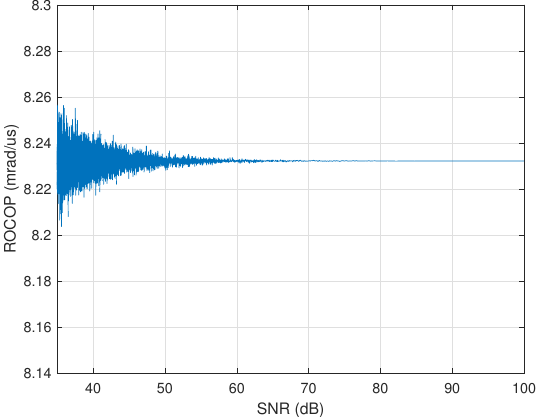
Figure 10. SNR-ROCOP response of I p for arc event 1.